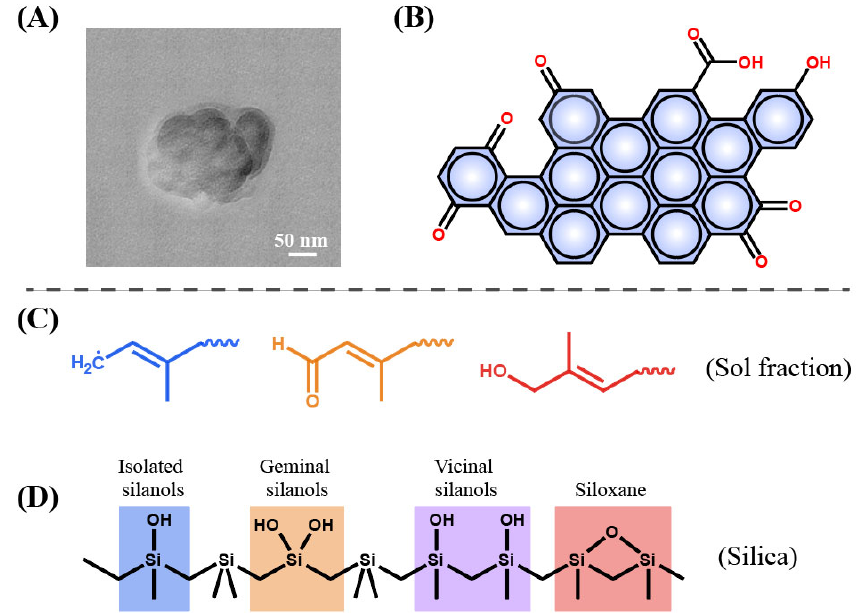
Figure 5. Components of DR. ( A ) TEM micrographs of CB [25]; ( B ) surface chemistry of CB [31]; ( C ) surface chemistry of silica [30]; ( D ) chemical formula of low molecular sol fraction [32].